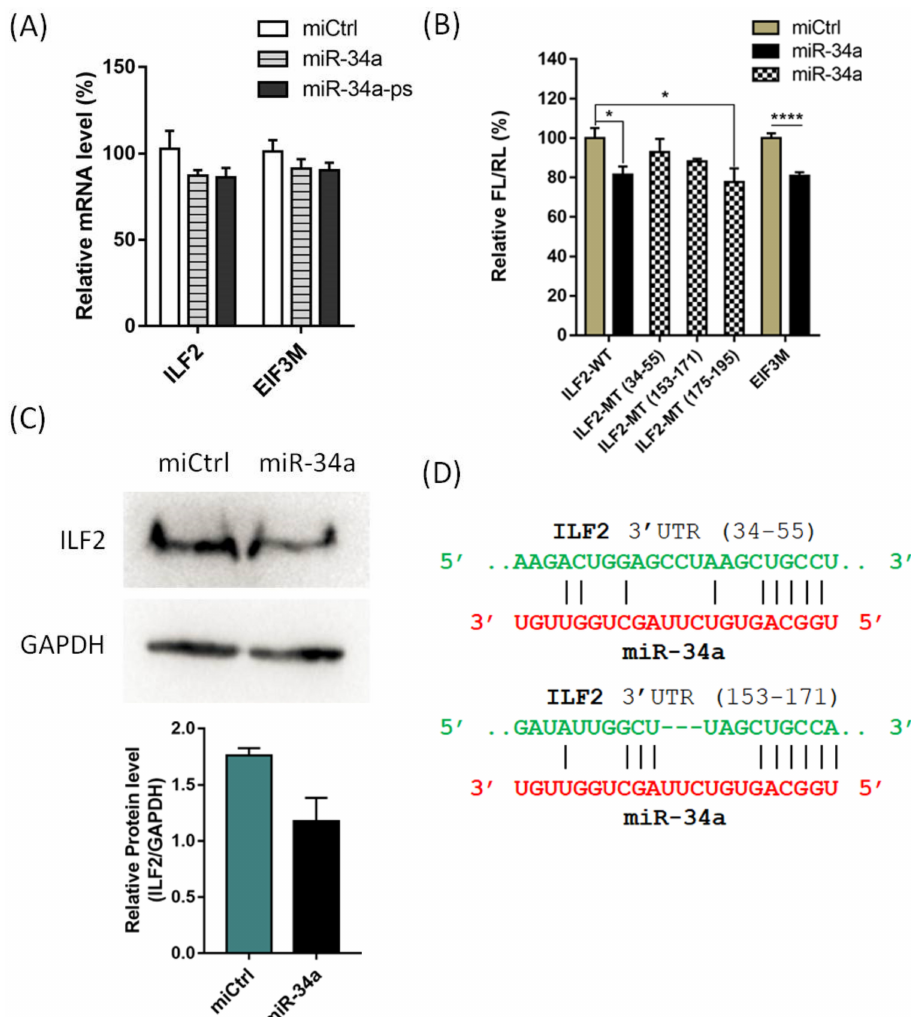
Figure 6. Validation of potential targets of miR-34a. ( A ) qPCR analysis of 2 potential targets that were specifically downregulated by miR-34-ps; ( B ) Dual luciferase assay showed that ILF2 and EIF3M have direct binding site(s) of miR-34a in the 3 (cid:48) UTR region of mRNA. WT represents wildtype 3 (cid:48) UTR-containing vectors and MT represents mutant type 3 (cid:48) UTR-containing vectors; ( C ) Western blotting analysis showed that ILF2 protein level was significantly decreased in A549 cells transfected with miR-34a; ( D ) Potential binding sites of miR-34a in the 3 (cid:48) UTR of ILF2 mRNA (by FIMO [41] program). All of the error bars represent mean ± SD of three independent experiments, and samples with p < 0.05 (one-way ANOVA) are marked with asterisks (*, p < 0.05; ****, p <